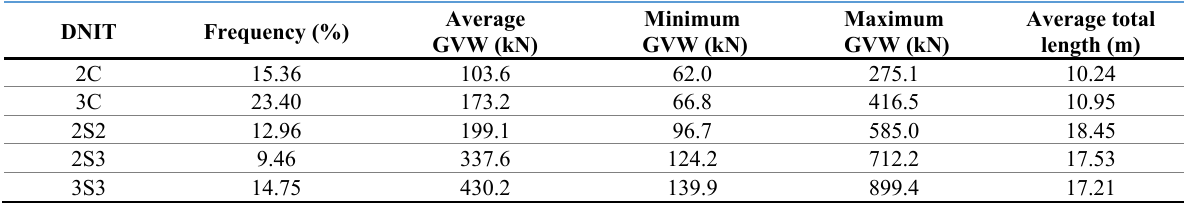
Table 2. Statistics for main classes of BR-381 (adapted from Portela [15]).